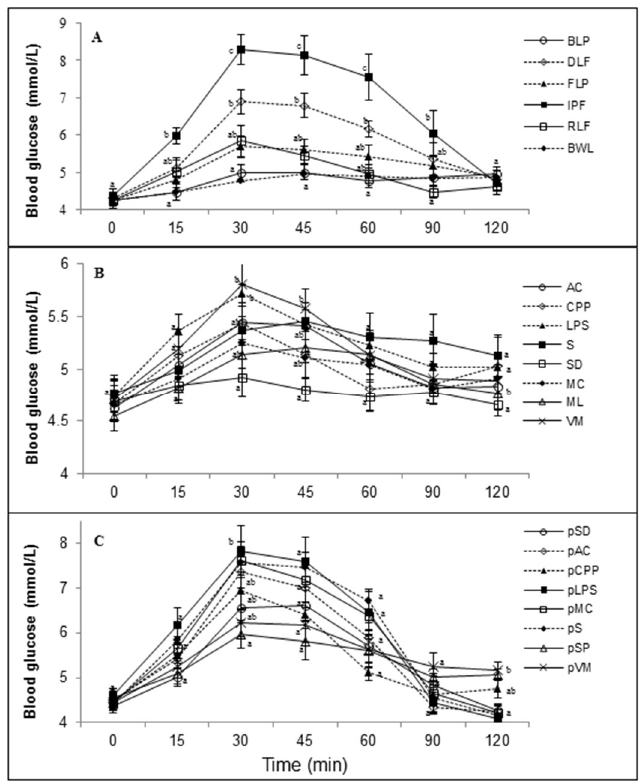
Figure 1. Blood glucose responses elicited by the different study foods. ( A ) Processed lentil